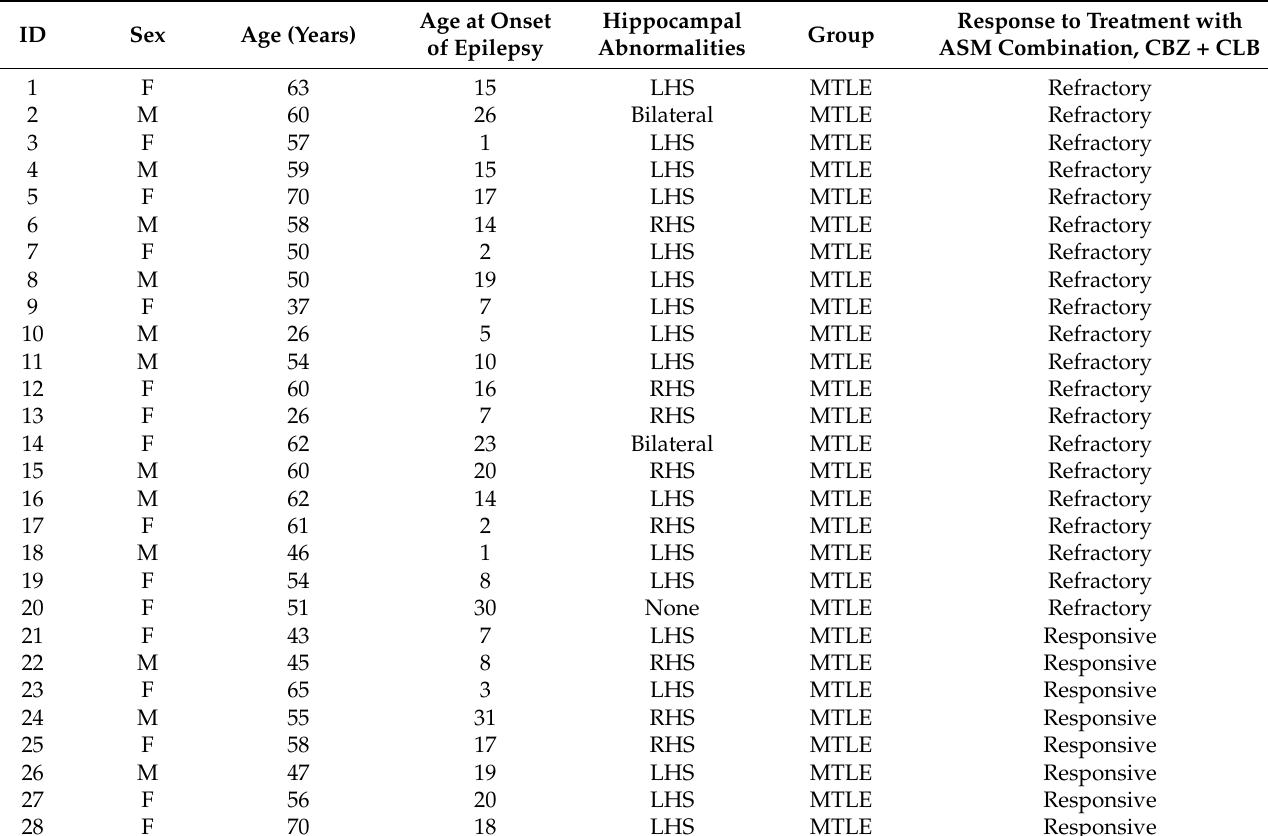
Table 1. The main characteristics of the 28 patients with MTLE included in the study. All patients were using the ASM combination, CBZ + CLB, and most of them presented signs of hippocampal sclerosis on magnetic resonance imaging—decreased hippocampus volume in T1 images with increased signal in T2/FLAIR